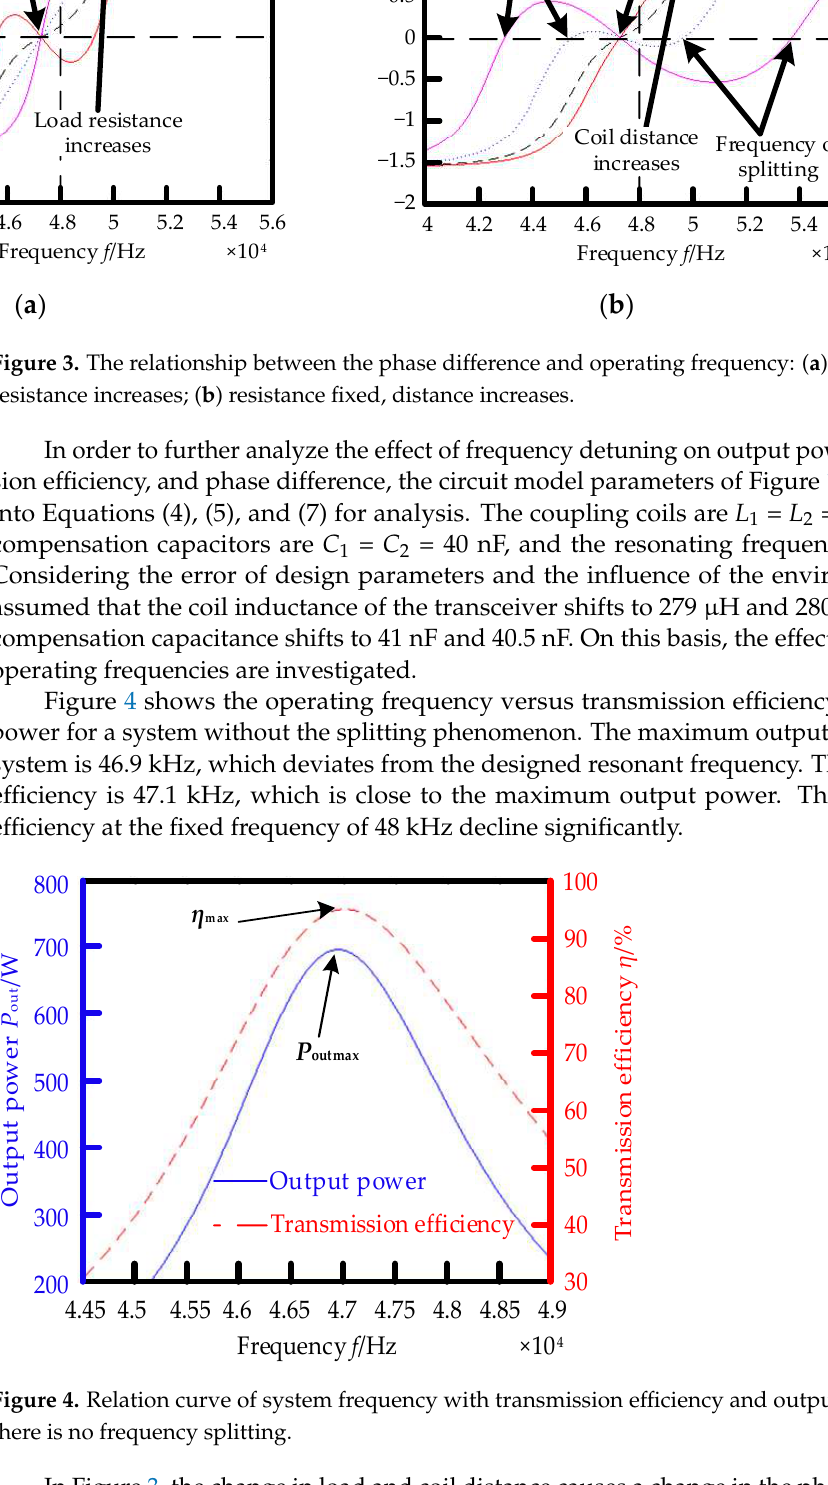
( b ) Figure 5. Voltage and current waveforms when the system is capacitive: ( a ) R L = 5 Ω, coil distance of 25 cm; ( b ) R L = 15 Ω, coil distance of 15 cm. The frequency-tracking method usually tracks the transmitter’s current to achieve the same frequency and phase voltage of the inverter output. In practice, the signal delays are due to the acquisition circuit, the over-zero comparison circuit, the dead zone, and the